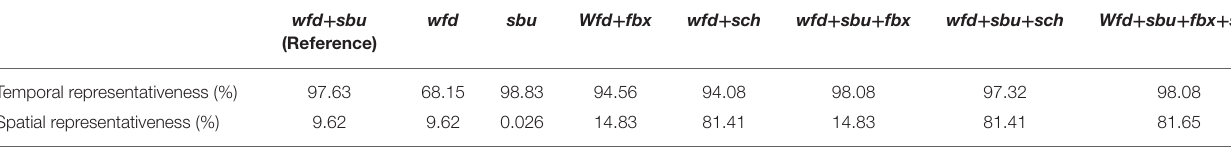
TABLE 5 | Temporal and spatial representativeness of the chlorophyll reference dataset and all the aggregation scenarios.